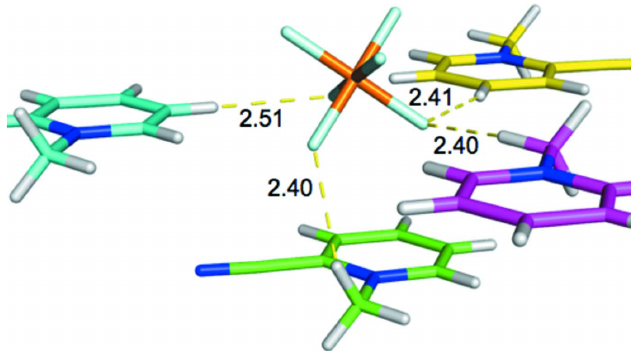
Figure 12 2-CMP + (cid:2)(cid:2)(cid:2) PF 6 (cid:3) interactions. BLYP-D3/def2-TZVP/SMD interaction energies (kcal mol (cid:3) 1 ) for these complexes are: (cid:3) 19.0 (green), (cid:3) 16.9 (cyan), (cid:3) 15.9 (purple), and (cid:3) 15.7 (yellow).